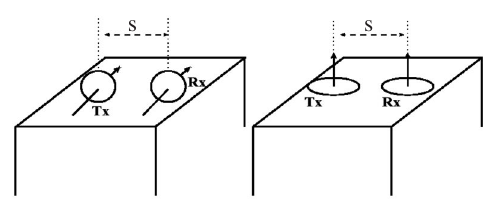
Fig. 1. Instrument configurations: horizontal ( left ) and vertical dipoles ( right